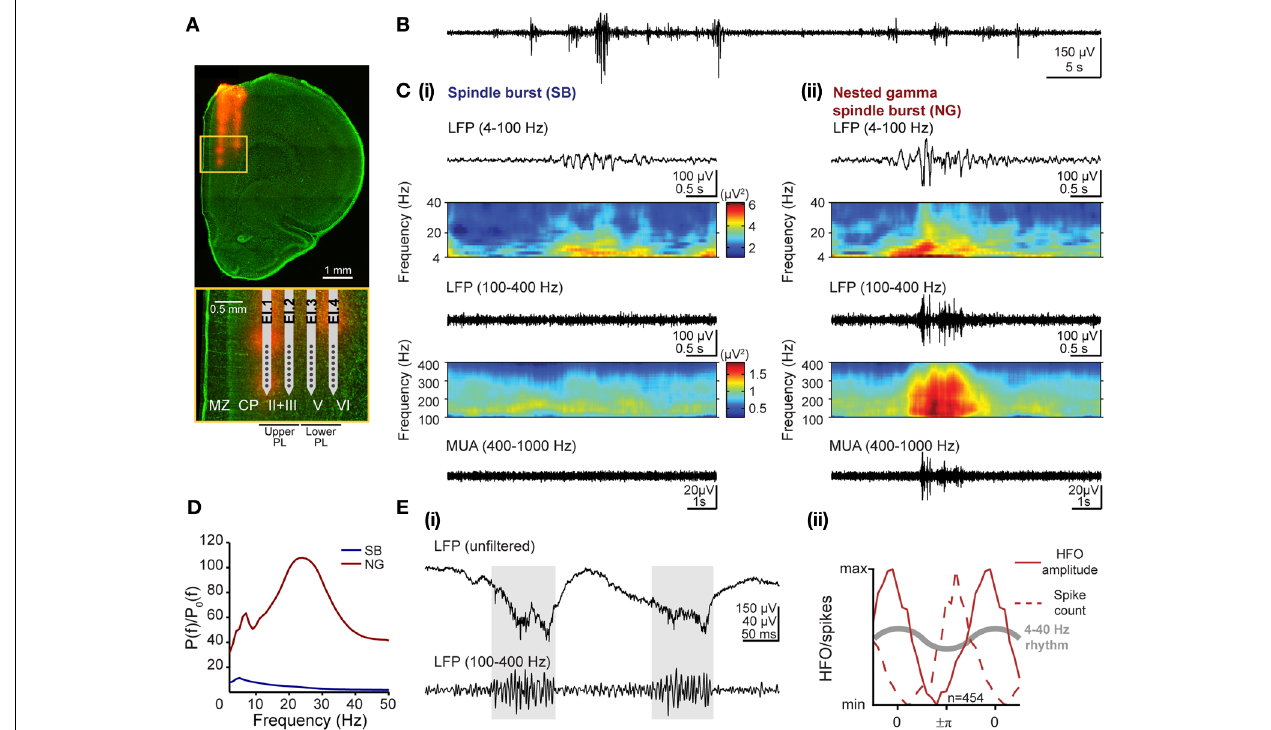
FIGURE 1 | Patterns of network activity and their frequency components in the developing prelimbic cortex of rats. (A) Digital photomontage reconstructing the location of the DiI-labeled 4-shank recording electrode (orange) in the PFC of a Nissl-stained 100 μ m-thick coronal section (green) from a P8 rat. Inset, drawing of the 4 × 8 electrode with horizontal spacing of 200 μ m and vertical spacing of 50 μ m according to the DiI-stained tracks within upper and lower cortical layers, which are displayed at higher magnification (yellow box). (B) Extracellular LFP recording (4–100Hz) of the discontinuous oscillatory activity in the PFC of a P8 rat. (C) Examples of characteristic SB (i) and NG (ii) displayed after band-pass (top: 4–100Hz, bottom: 100–400Hz) filtering and accompanied by the color-coded frequency plots showing the wavelet spectra of the LFP at identical time scales. Both plots for one filter range are scaled identically corresponding to the color bars